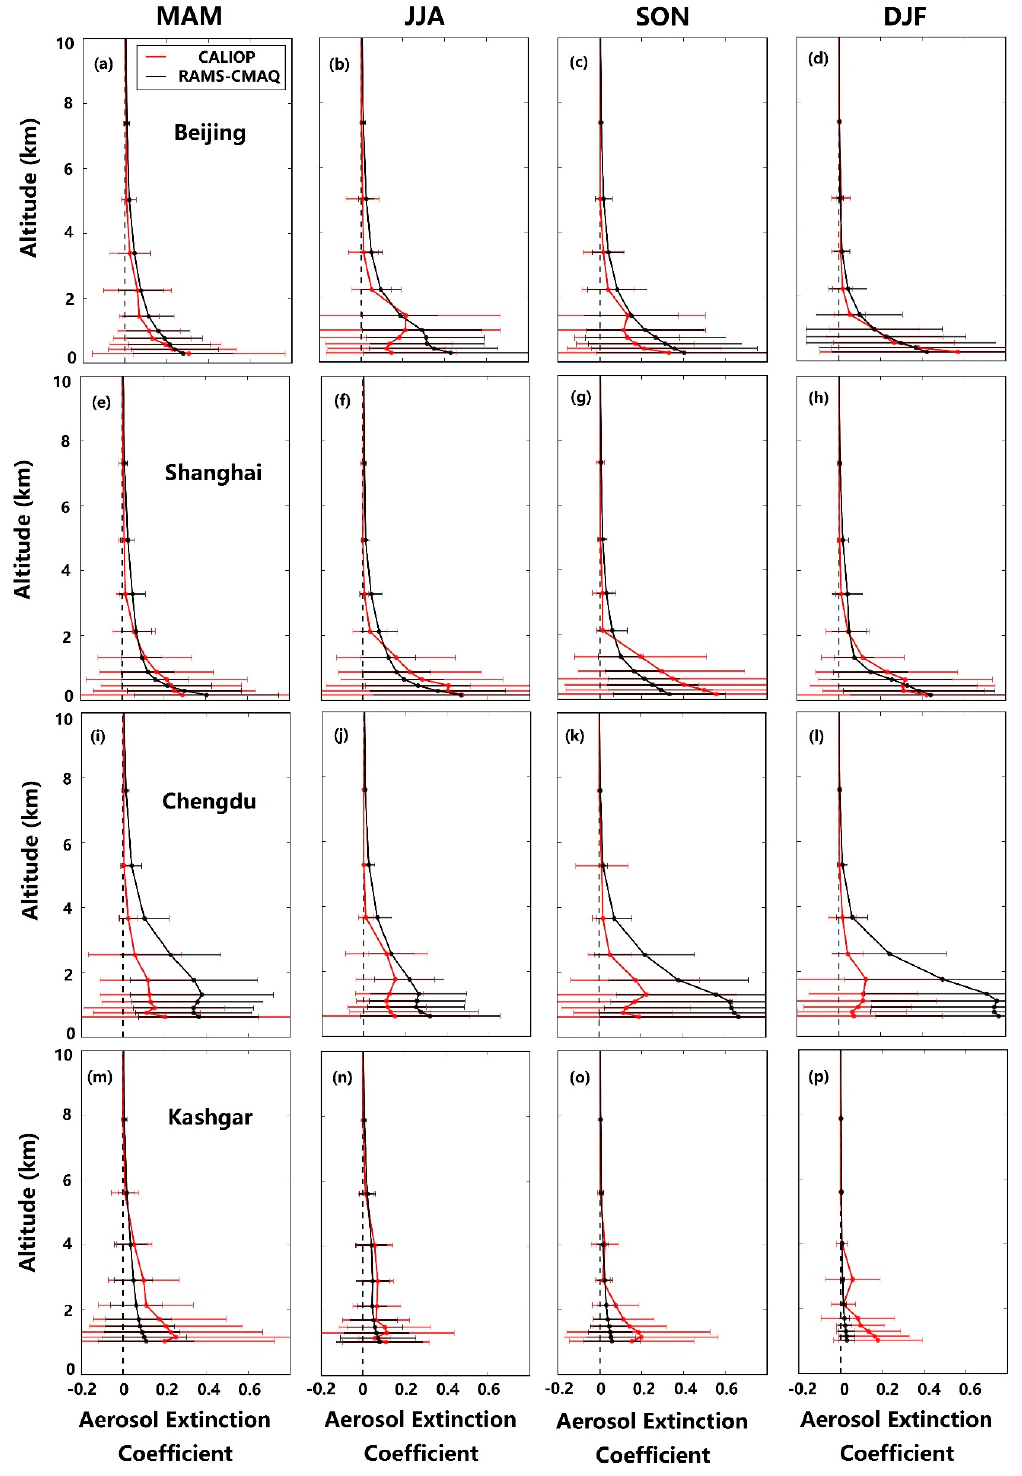
Figure 5. Comparison of the CALIOP measured and RAMS-CMAQ simulated AEC profiles (unit: km − 1 ) in 550 nm wavelength at four seasons and locations: ( a – d ) Beijing; ( e – h ) Shanghai; ( i – l ) Chengdu; ( m – p ) and the Taklimakan desert region. The horizontal red bars indicate the + σ (SDV) of the CALIOP-derived AEC. The black bars indicate the + σ (SDV) of the RAMS-CMAQ-simulated AEC.